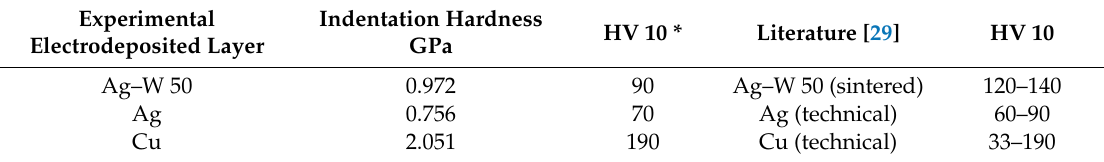
* Converted to Vickers hardness according to manufacturer